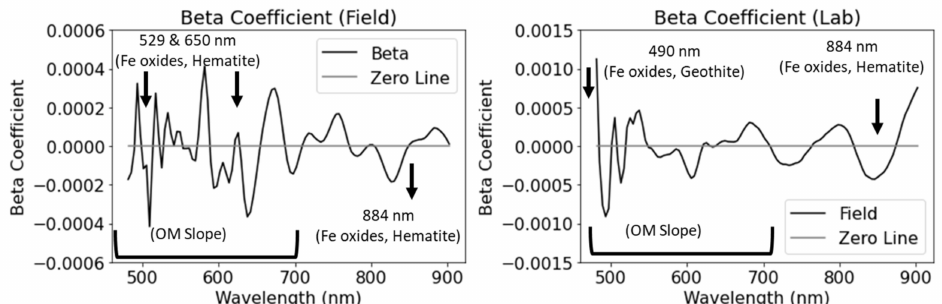
Figure 8. Beta coefficients of the PLSR models for the prediction of WIR using all samples, with the resampled data (to the Cubert spectral resolution).